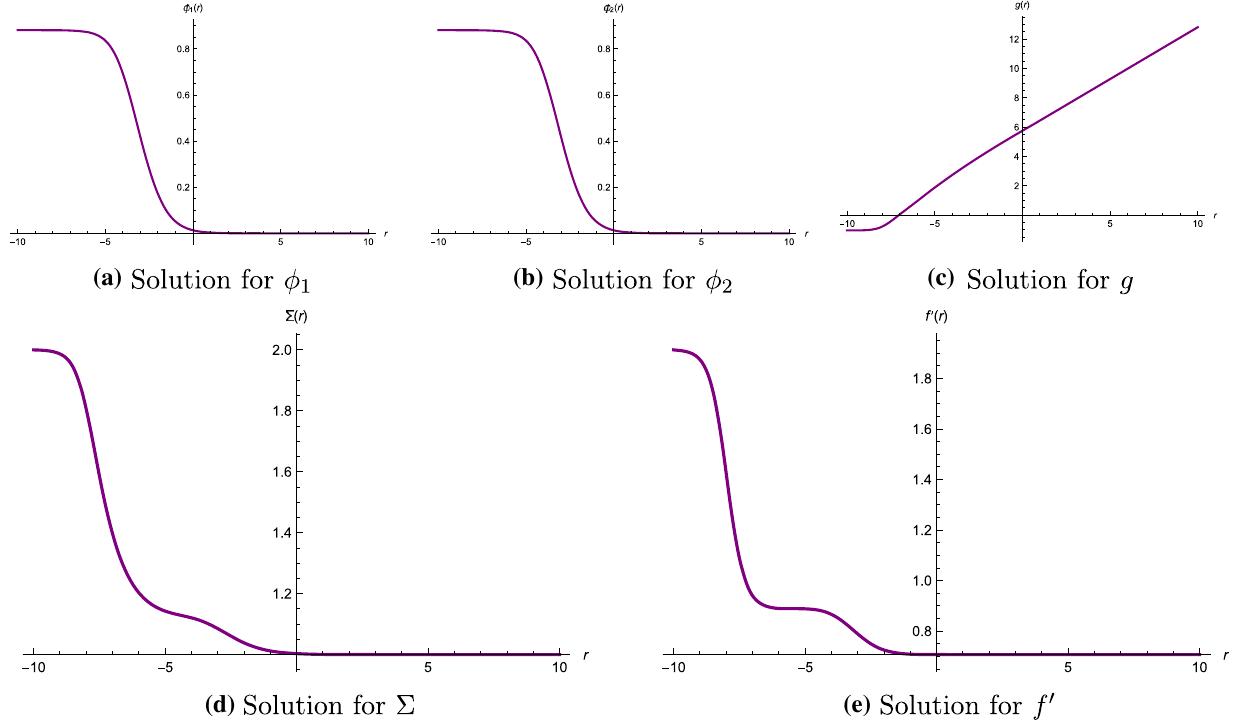
Fig. 5 An RG flow from AdS 5 critical point with U ( 1 ) × SU ( 2 ) × SU ( 2 ) symmetry to AdS 5 critical point with U ( 1 ) × SU ( 2 ) diag symmetry and finally to AdS 3 × S 2 critical point II for g 1 = 1, g 3 = 2 g 1 and a 5 = 1